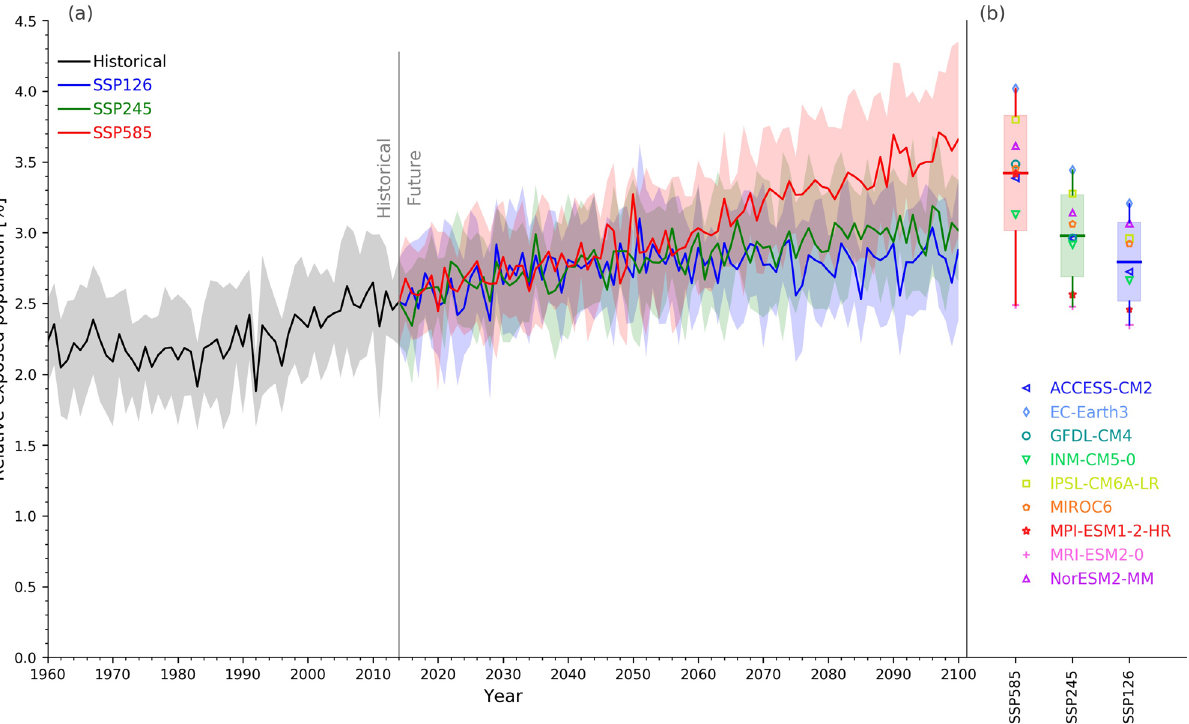
Figure 2. Global potential flood exposure change and uncertainty. Global potential flood exposure change (mean and one standard deviation among AOGCMs, indicated by as shading) for the multi-model median return period (years) in the future (2071–2100) for a discharge corresponding to a 100-year flood in the past (1971–2000).